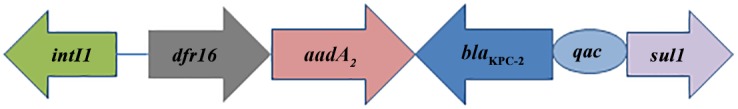
Genetic context of bla
KPC.